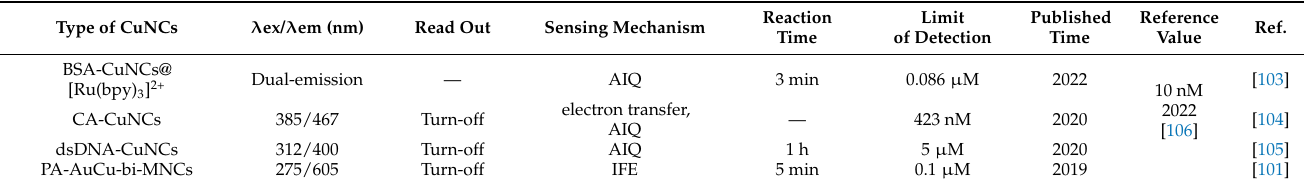
Table 3. The recent report on the detection of Fe 3+ by